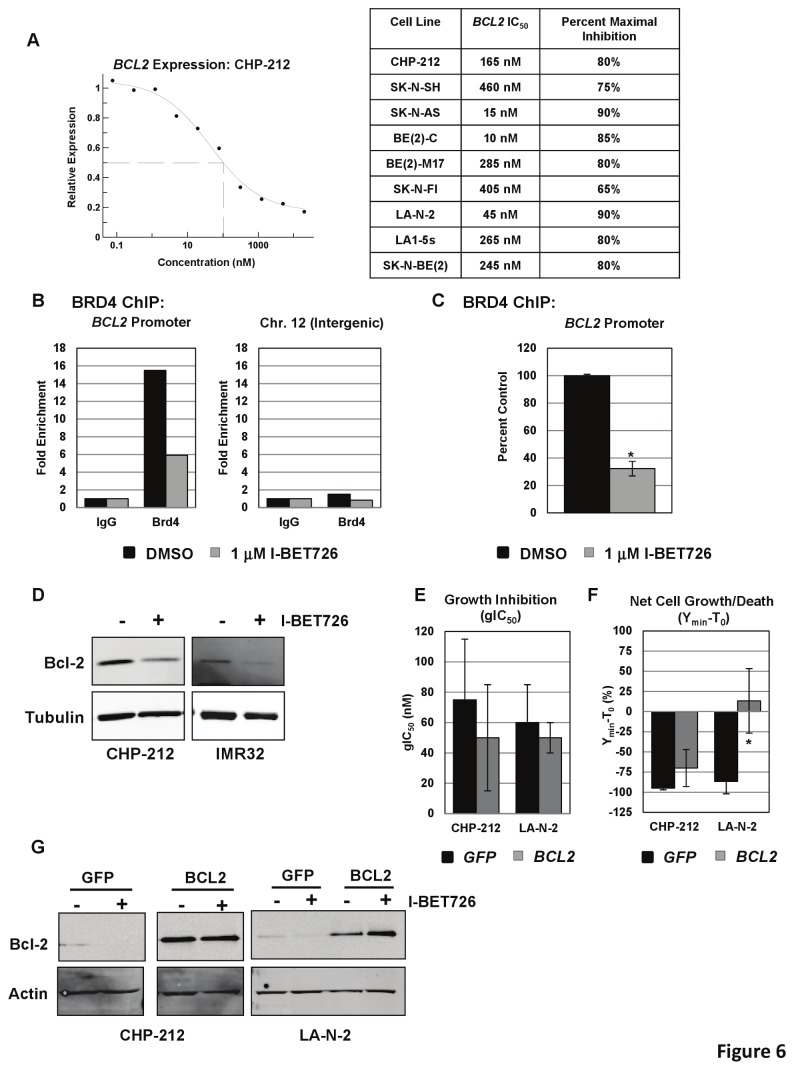
Suppression of BCL2 expression by I-BET726.(a) Left: Concentration response curve for BCL2 RNA expression following 24 hour treatment with I-BET726 in the CHP-212 cell line. Data was normalized to GAPDH and presented as expression relative to DMSO-treated controls. Data presented as the average of two independent curves from a single experiment, and is representative of data from two independent biological replicates. Right: Table of IC50 values and percent inhibition of BCL2 expression following 24 hour treatment with I-BET726. (b) BRD4 ChIP in the non-amplified neuroblastoma cell line SK–N–SH. Binding of BRD4 to the BCL2 promoter or to an intergenic region on Chromosome 12 following treatment with vehicle or 1 µM I-BET726 for six hours. Data is presented as fold enrichment over signal generated from IgG control immunoprecipitations. Data shown was from a single experiment representative of typical results. (c) BRD4 ChIP data at the BCL2 promoter, presented as percent of vehicle control signal. Data represent the mean value ± standard deviation for three independent biological replicates. Asterisk indicates statistical significance as measured by T-test (p= 0.002). (d) Western blot analysis of Bcl-2 expression in the MYCN-amplified cell lines CHP-212 and IMR32 following 48 hour treatment with vehicle or 1 µM I-BET726. Tubulin expression included as a loading control. (e) gIC50 values obtained from CHP-212 or LA-N-2 cells overexpressing GFP or BCL2 following treatment with I-BET726 in a 6 day growth-death assay. Data represents the mean value ± standard deviation from three independent experiments. (f) Ymin-T0 values for CHP-212 or LA-N-2 cells overexpressing GFP or BCL2. Data represents the mean value ± standard deviation from three independent experiments. Asterisk indicates statistical significance as measured by t-test (p= 0.02). (g) Western blot analysis of Bcl-2 expression in CHP-212 or LA-N-2 cells overexpressing GFP or BCL2 following 48 hour treatment with DMSO or 1 µM I-BET726. Actin expression included as a loading control.